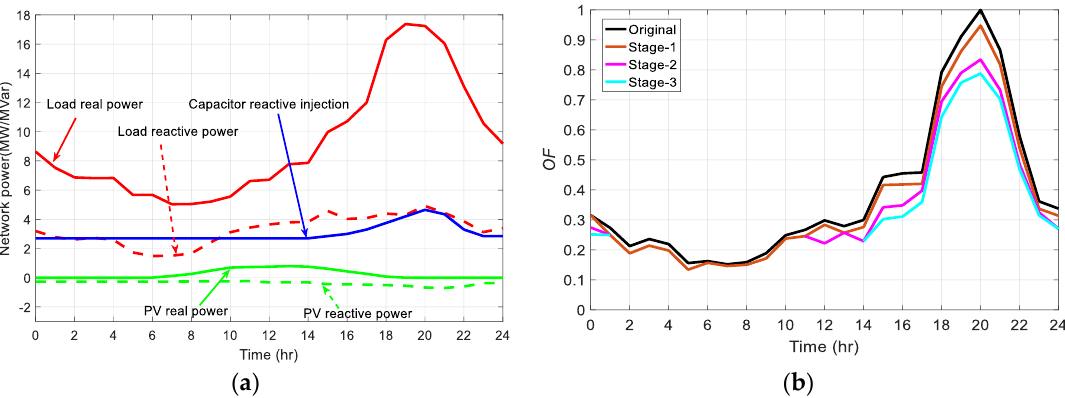
Figure 12. Comparison of the ( a ) power profiles; ( b ) Optimization objectives, for the considered network of Figure 11, over 24 h.